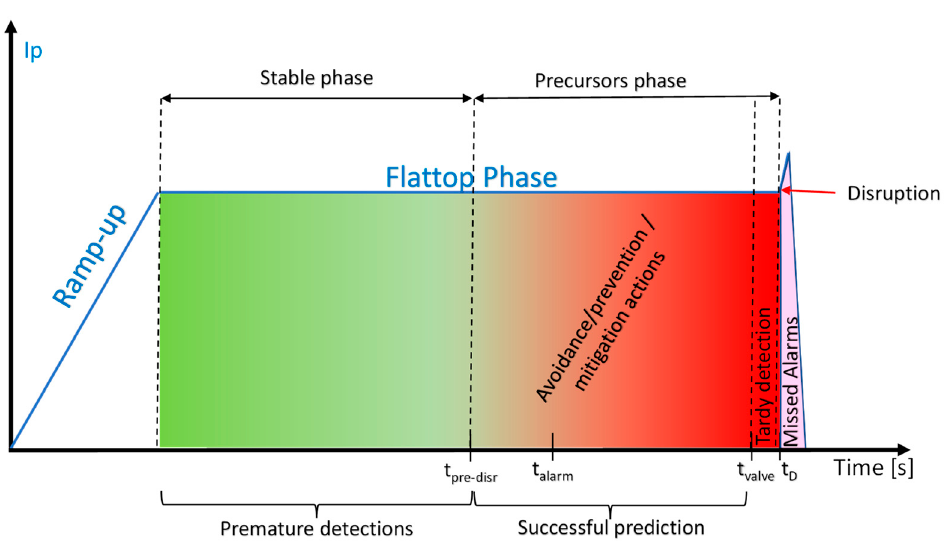
Figure 1. Sketch of the plasma current evolution in a disrupted discharge.